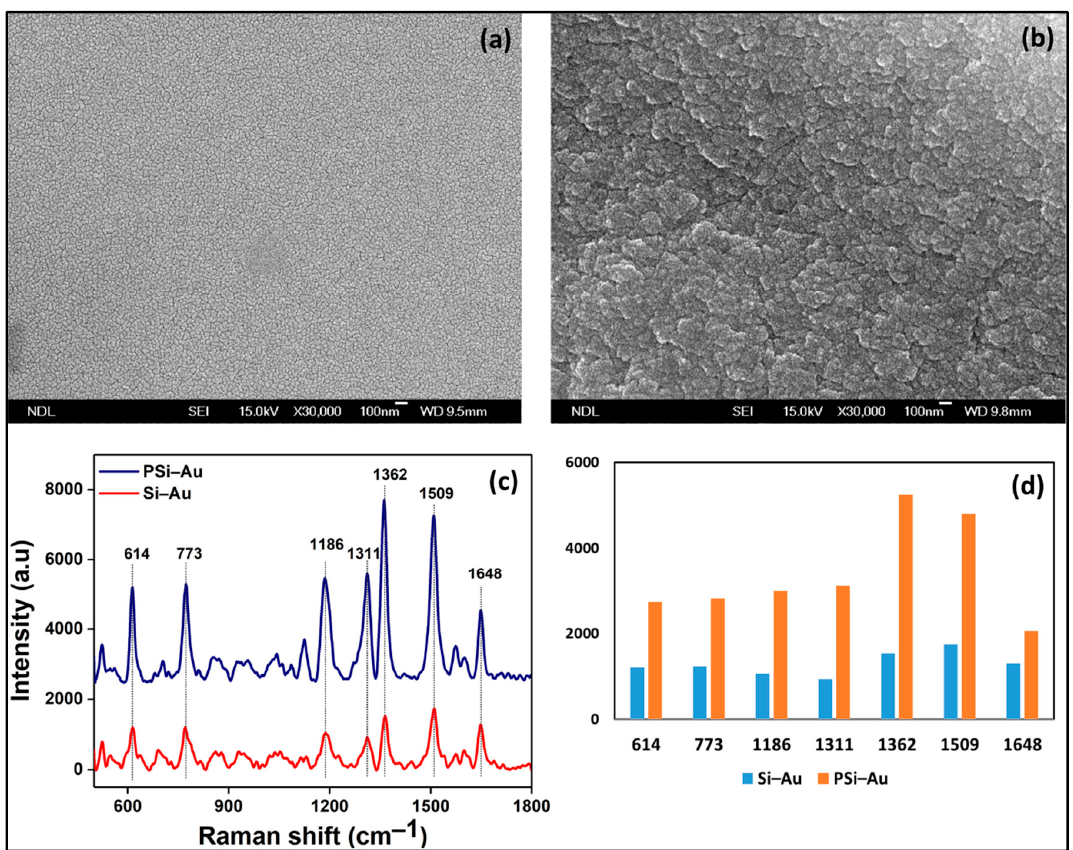
Figure 5. SEM images of ( a ) Si–Au thin films, and ( b ) PSi–Au thin films. ( c ) SERS spectra of both Si–Au and PSi–Au thin film composites, and ( d ) comparison of the SERS peak intensity of the two SERS substrates.